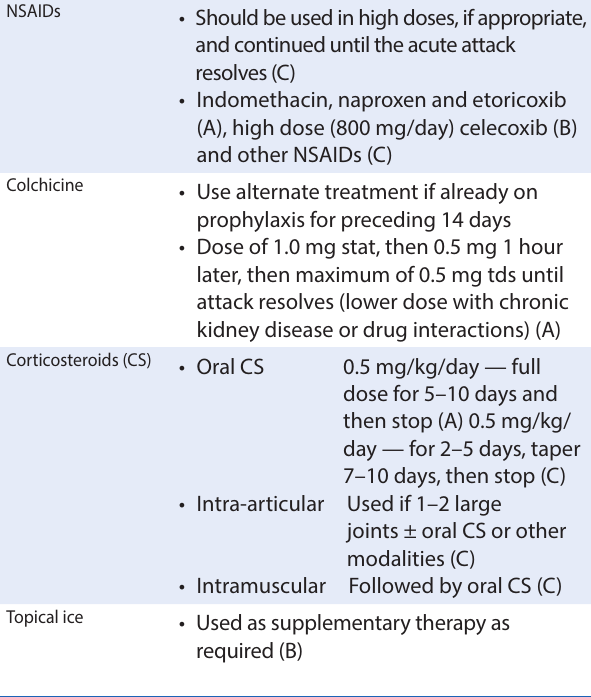
Table 1: Treatment of the acute attack of gout (level of evidence in parentheses) 8 NSAIDs